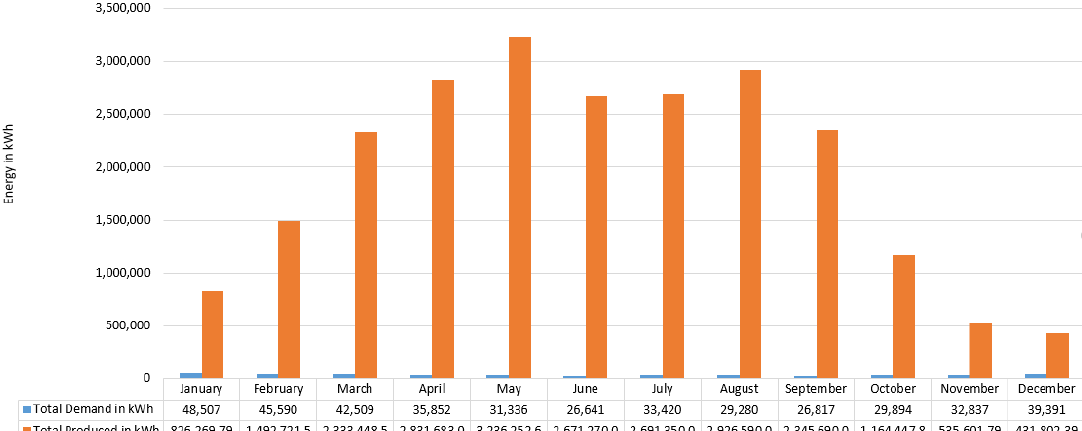
Figure 6. CMX electrical demand for each month vs. solar electrical production (after snow losses) for case study 1 [90]. case study 1